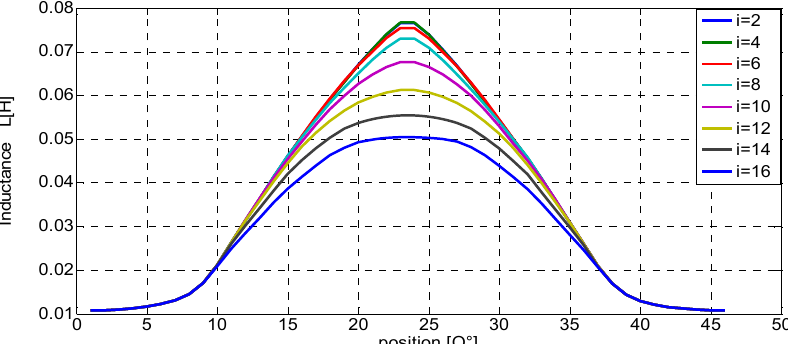
Figure 4. Inductance characteristics as a function of the rotor position for currents ranging from 2 to 16 A.